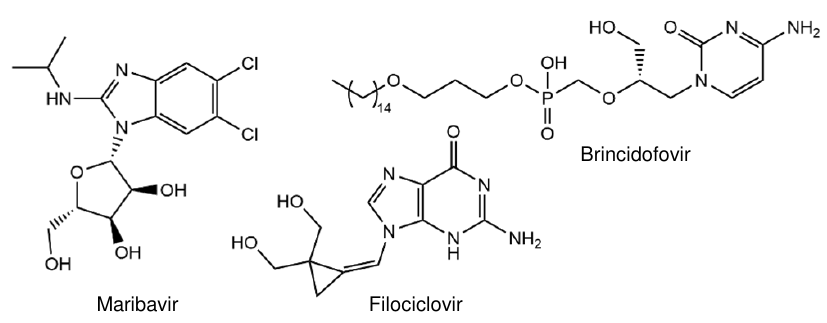
Figure 2. Structures of antivirals in clinical